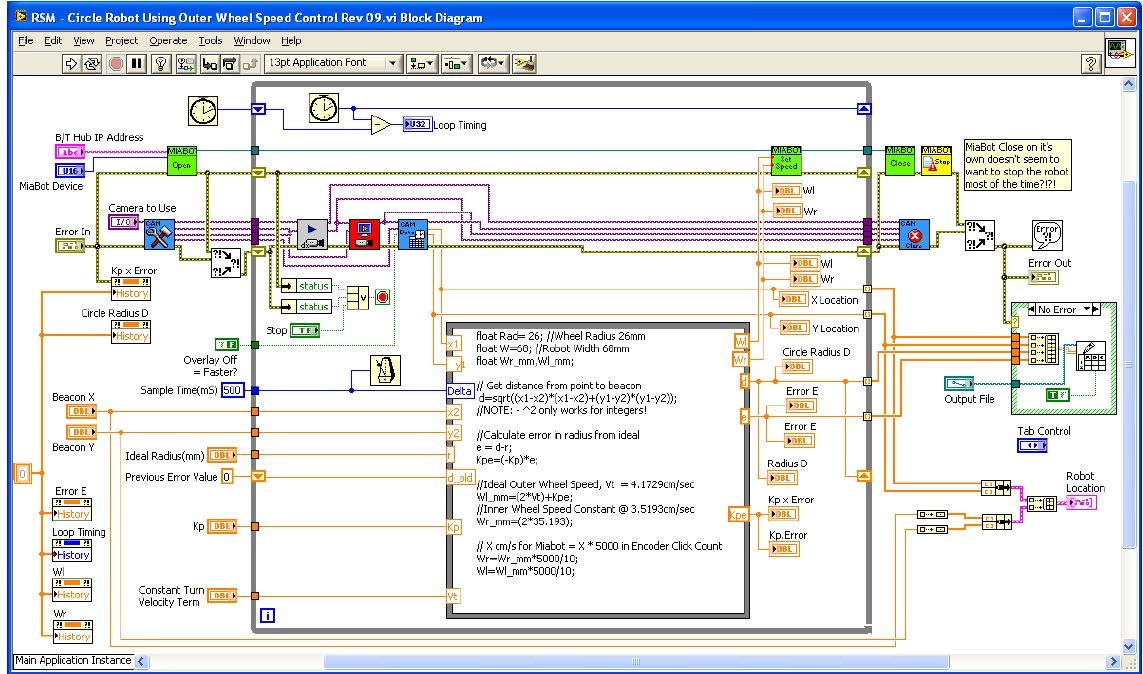
LabVIEW implementation of the Proportional-only Con- troller using the overhead camera system and testbed’s communication channel to achieve stable circular motion at a desired radius around a designated beacon. In order to achieve deterministic loop executed, LabVIEW used a timed while loop to ensure timing constraints and asso- ciated timing errors were minimised. Each loop iteration also used the previous iteration’s actual completion time as an approximation of the current loop’s execution time, in a further attempt to minimise errors due to the variability of LabVIEW’s sampling period.